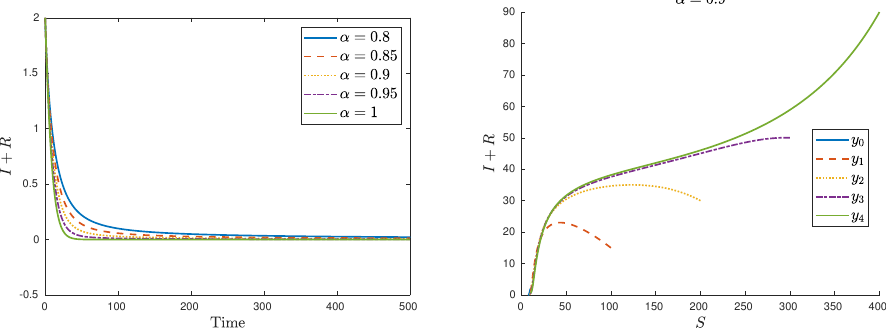
= 8,0,0 ) , for the SIRS fractional model µ